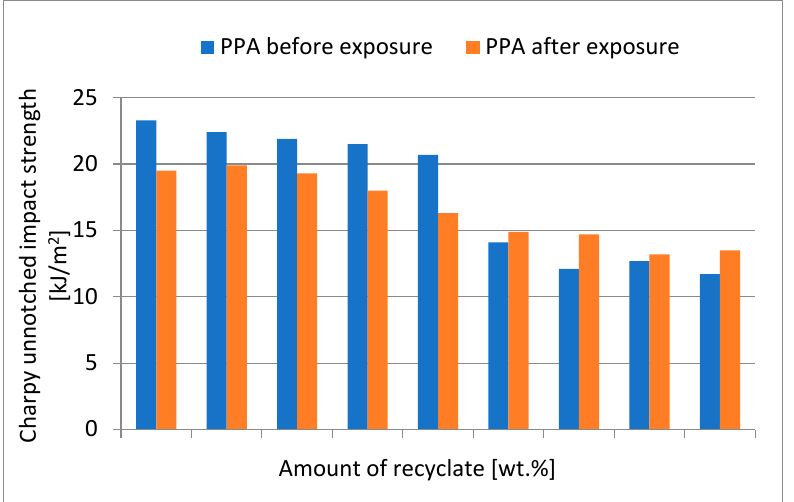
Figure 9. Dependence of the unnotched impact strength of PPA on the amount of recycled material before and after the samples were exposed to elevated temperature ( − 30 °C).